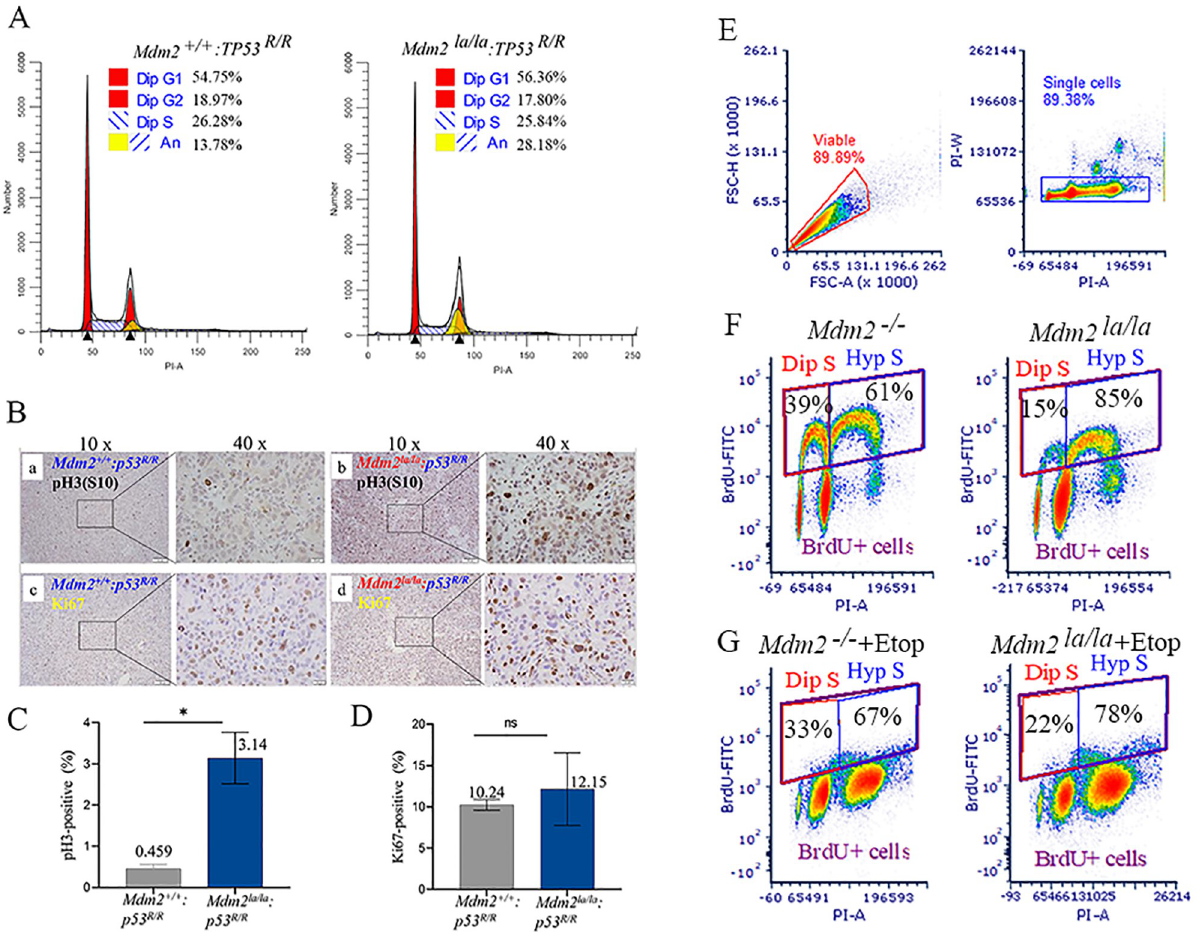
Fig 3. p53-null Mdm2 la/la MEFs and sarcoma cells have defects in and increased and G2-M transition hyperploidy. ( A ) Cell cycle profiles of Mdm2 la/la : TP53 R/R and Mdm2 +/+ : TP53 R/R MEFs (passage 6) by flow cytometry. Dip, diploid, An, aneuploid. ( B ) Increased phospho-Histone 3 at Serine 10 (pH3(S10) in p53 -deficient Mdm2 la/la sarcoma tissues. Representative histochemical staining of pH3(S10) (a, b) and Ki67 (c, d) in sarcoma tissues from p53 -/- : Mdm2 +/+ (a, c) or p53 -/- : Mdm2 la/la (b, d) mice. Left images at 10x magnification and at 40x magnification of image areas in frame shown on the right. ( C ) Quantitative analysis of pH3(S10) staining in two p53 -/- : Mdm2 +/+ and three p53 -/- : Mdm2 la/la sarcoma samples. � , t test, p = 0.0106. ( D ) Quantitative analysis of Ki67-positive cells in two p53 -/- : Mdm2 +/+ and three p53 -/- : Mdm2 la/la sarcoma samples. ns, t test, p = 0.604. ( E ) Mdm2 +/+ -tetp53 and Mdm2 la/la -tetp53 MEFs were used for BrdU labeling experiments. Gating settings are shown to define viable, singlet and BrdU- positive cells. ( F ) Diploid S (Dip S) and hyperploid S (Hyp S) fractions of Mdm2 +/+ -tetp53 and Mdm2 la/la -tetp53 MEFs were presented. ( G ) Diploid S (Dip S) and hyperploid S (Hyp S) fractions of etoposide-treated (5 μ M, 24h) Mdm2 +/+ -tetp53 and Mdm2 la/la -tetp53 MEFs were shown.